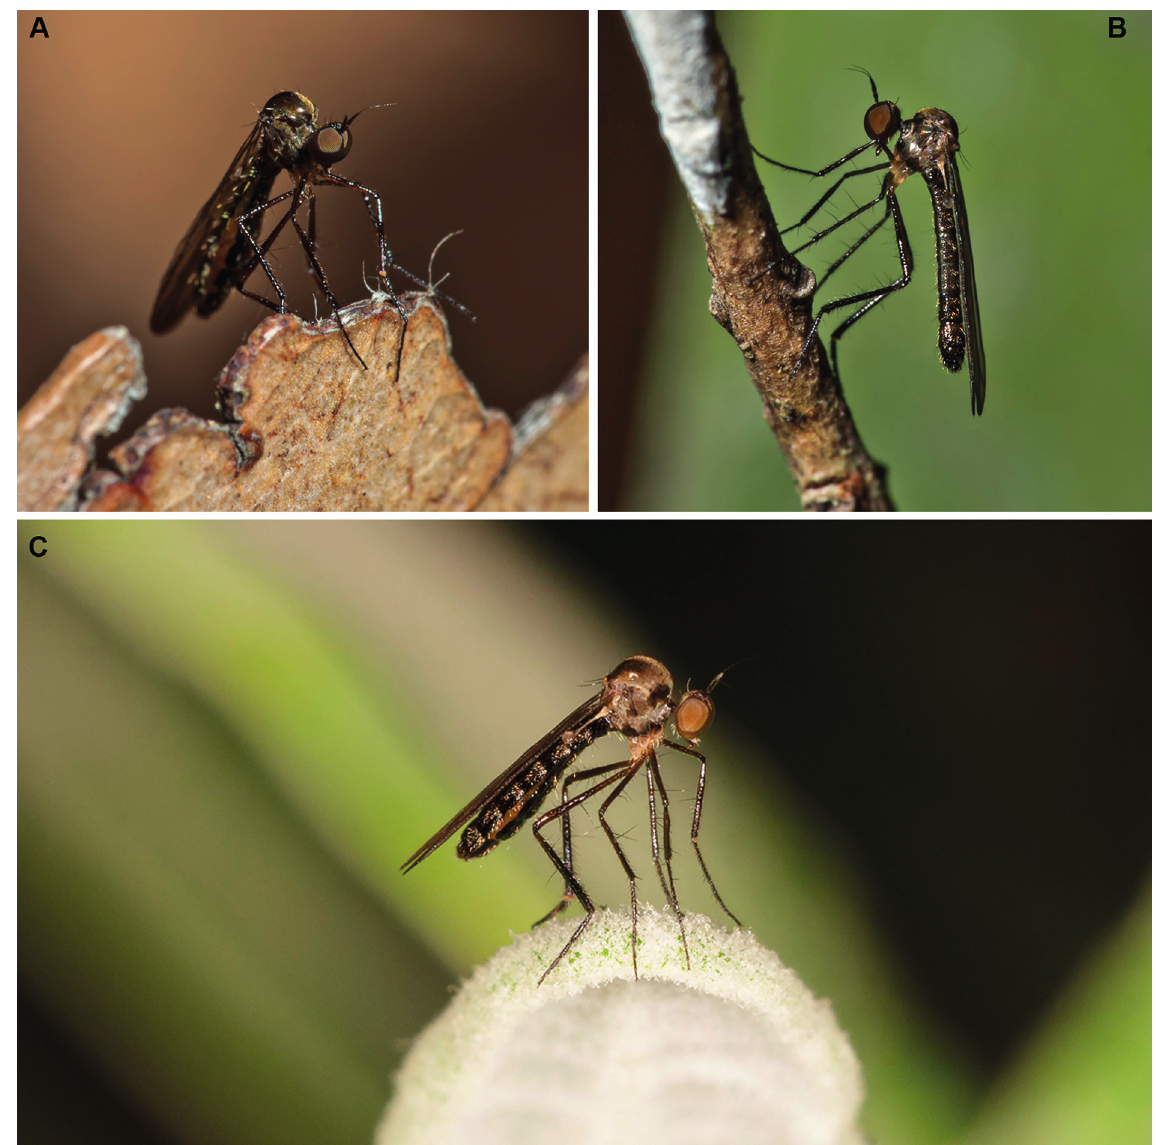
Fig. 5. Living specimens of Chvalaea Papp & Földvári, 2002 from the Australasian Region. A–B . Specimens resting on tips of branches (Geeveston, Tasmania), provided by Tony Daley. C . Specimen resting on a flower of Bedfordia salicina D.C. (Wellington Park, Tasmania), provided by Keith